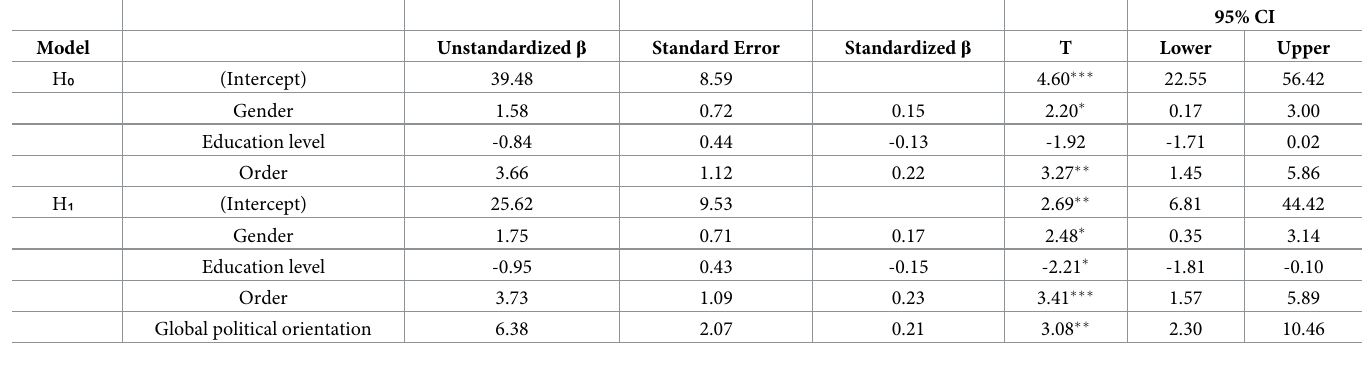
Table 5. Coefficients of hierarchical regression analysis for variables predicting sensitivity to social norm violation with general political orientation (n = 199).